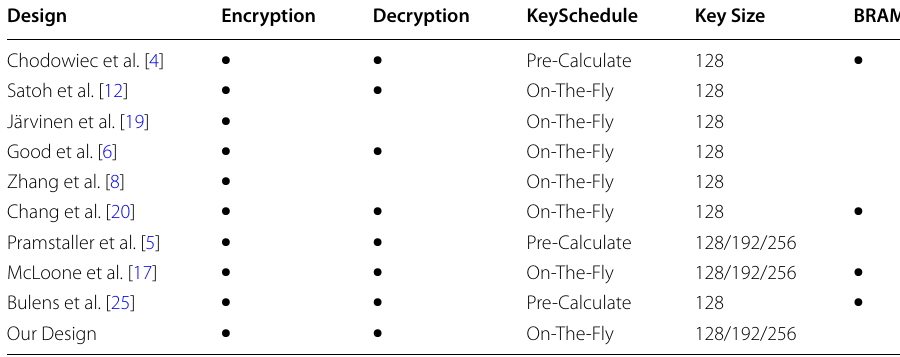
Table 3 Function comparisons of different AES architectures Design